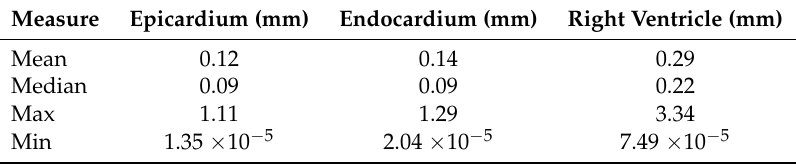
Figure 3. Parallel Coordinate graph showing the different combinations of parameters giving the minimum average, median, and min mesh to mesh distance, as well as the number of triangles generated. The red lines represent the selected bands for the y -axis. The highlighted blue lines represent the parameters that have generated meshes that satisfies the selected criteria. The faded lines represent every parameter permutation and their respective evaluation metrics. There are 3440 permutations. The fifth to seventh y -axis represent the mean, median and min mesh-to-mesh error distances in mm, between the ground truth meshes and the generated meshes given the respective parameters. Table 1. Table depicting the mesh-to-mesh distances (in mm) between the ground truth surface meshes and our generated meshes for 40 different geometries.